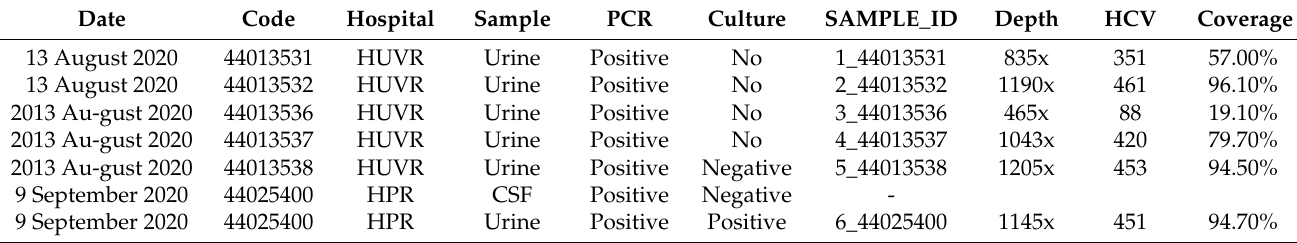
Table 1. WNV samples studied and some statistics on the viral sequencing process. Samples came from Hospital Virgen del Roc í o (HUVR), Seville, and Hospital Puerto Real (HPR), C á diz. Depth refers to the mean number of reads covering each position. High-confidence variants (HCV) refer to the variants unambiguously identified by the calling algorithm of the nf-core/viralrecon pipeline used, and the last column refers to the percentage of the viral genome covered in the sequencing